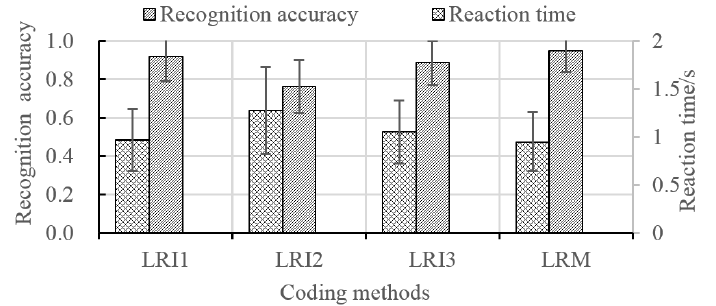
Figure 9. Recognition accuracy and reaction time (s) for each coding method in experiment 2. Error bars indicate standard